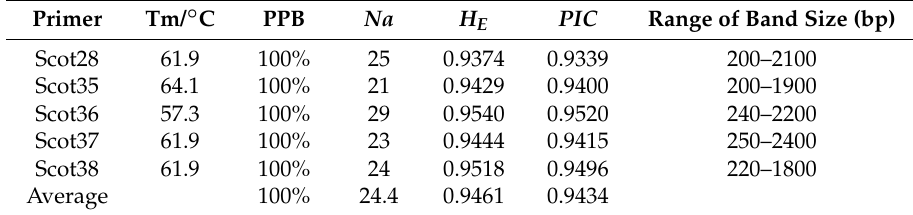
Table 6. Information for the five SCoT primers used in the genetic diversity analysis in common vetch.